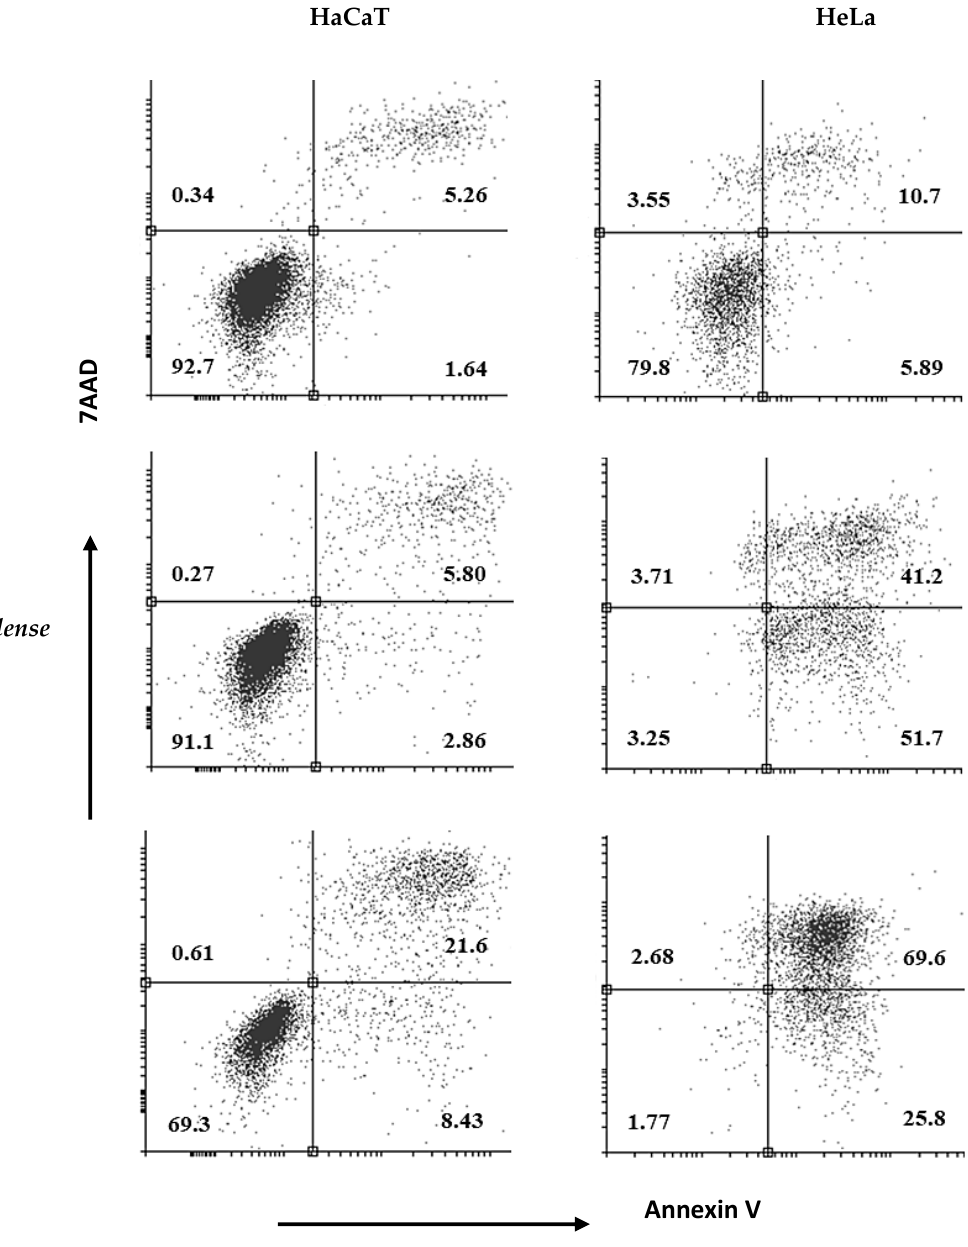
Figure 4. Apoptosis analysis upon treatment of HeLa and HaCaT cells with S. chinantlense extract at the IC 50 value. The distribution of cells undergoing early and late apoptosis together with viable cells was determined at 72 h in comparison to control or cisplatin at the IC 50 value, using Annexin V-FITC and propidium iodide flow cytometric analysis.